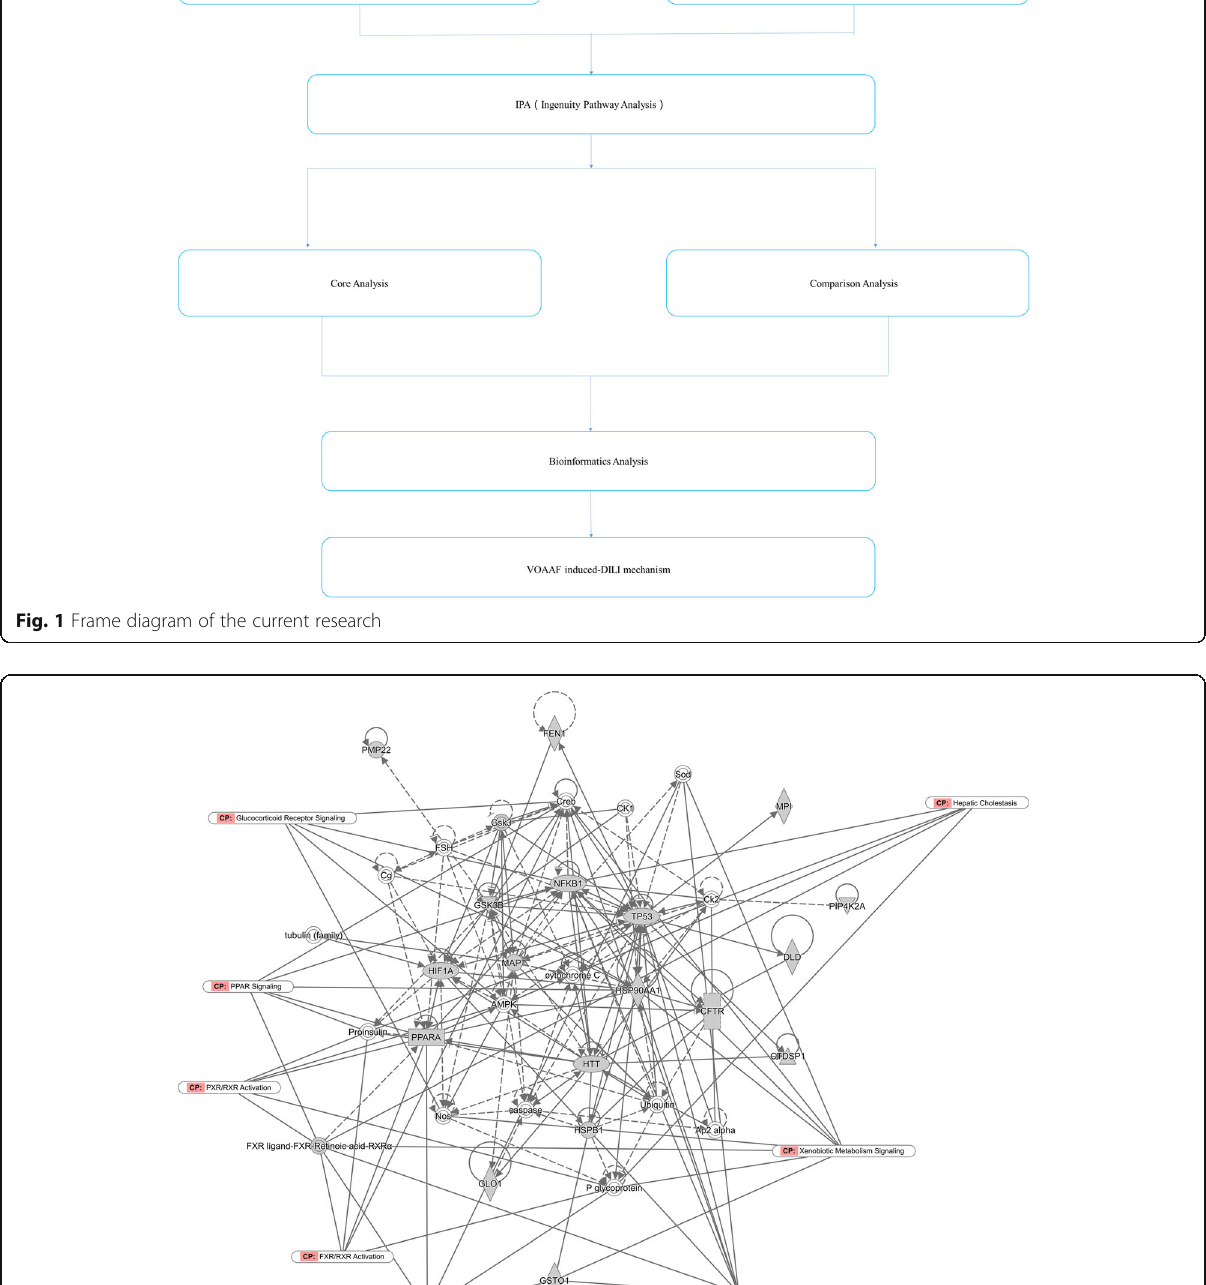
Fig. 2 The molecular network of